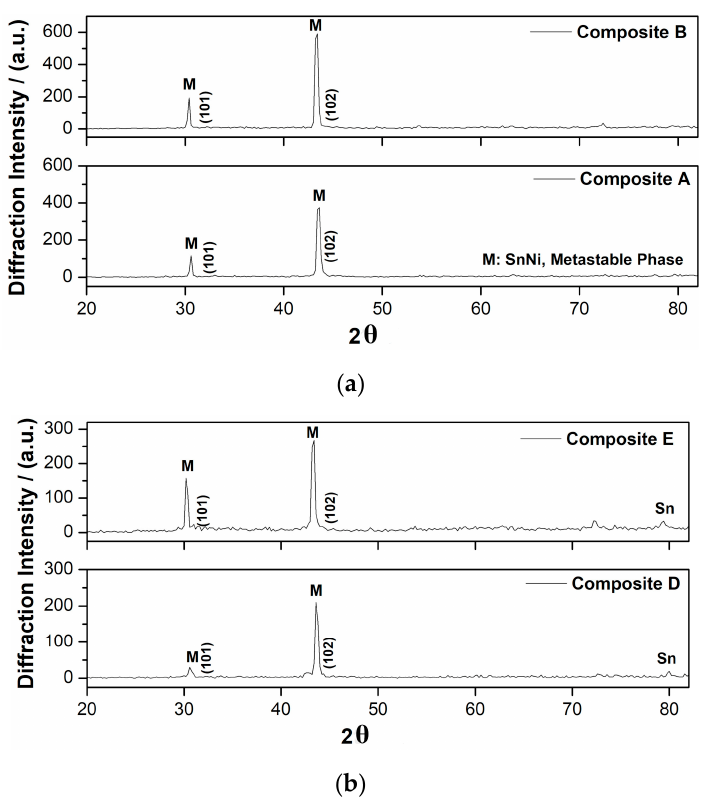
Figure 9. X-ray diffraction patterns of composites: ( a ) Sn–Ni/N,S-TiO 2 produced under J = 1 A·dm − 2 at Figure 9. X-ray di ff raction patterns of composites: ( a ) Sn–Ni / N,S-TiO 2 produced under J = 1 A · dm − 2 at 20 and 30 g·L − 1 TiO 2 and ( b ) Sn–Ni/Kronos 7000 TiO 2 deposits produced under J = 3 A·dm − 2 at 20 and 20 and 30 g · L − 1 TiO 2 and ( b ) Sn–Ni / Kronos 7000 TiO 2 deposits produced under J = 3 A · dm − 2 at 20 and 30 g·L − 1 TiO 2 loading. 30 g · L − 1 TiO 2